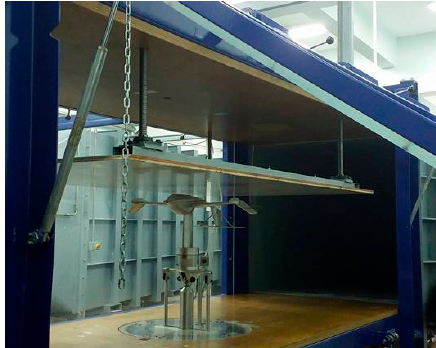
Figure 2. Wing and Ground Models Installation